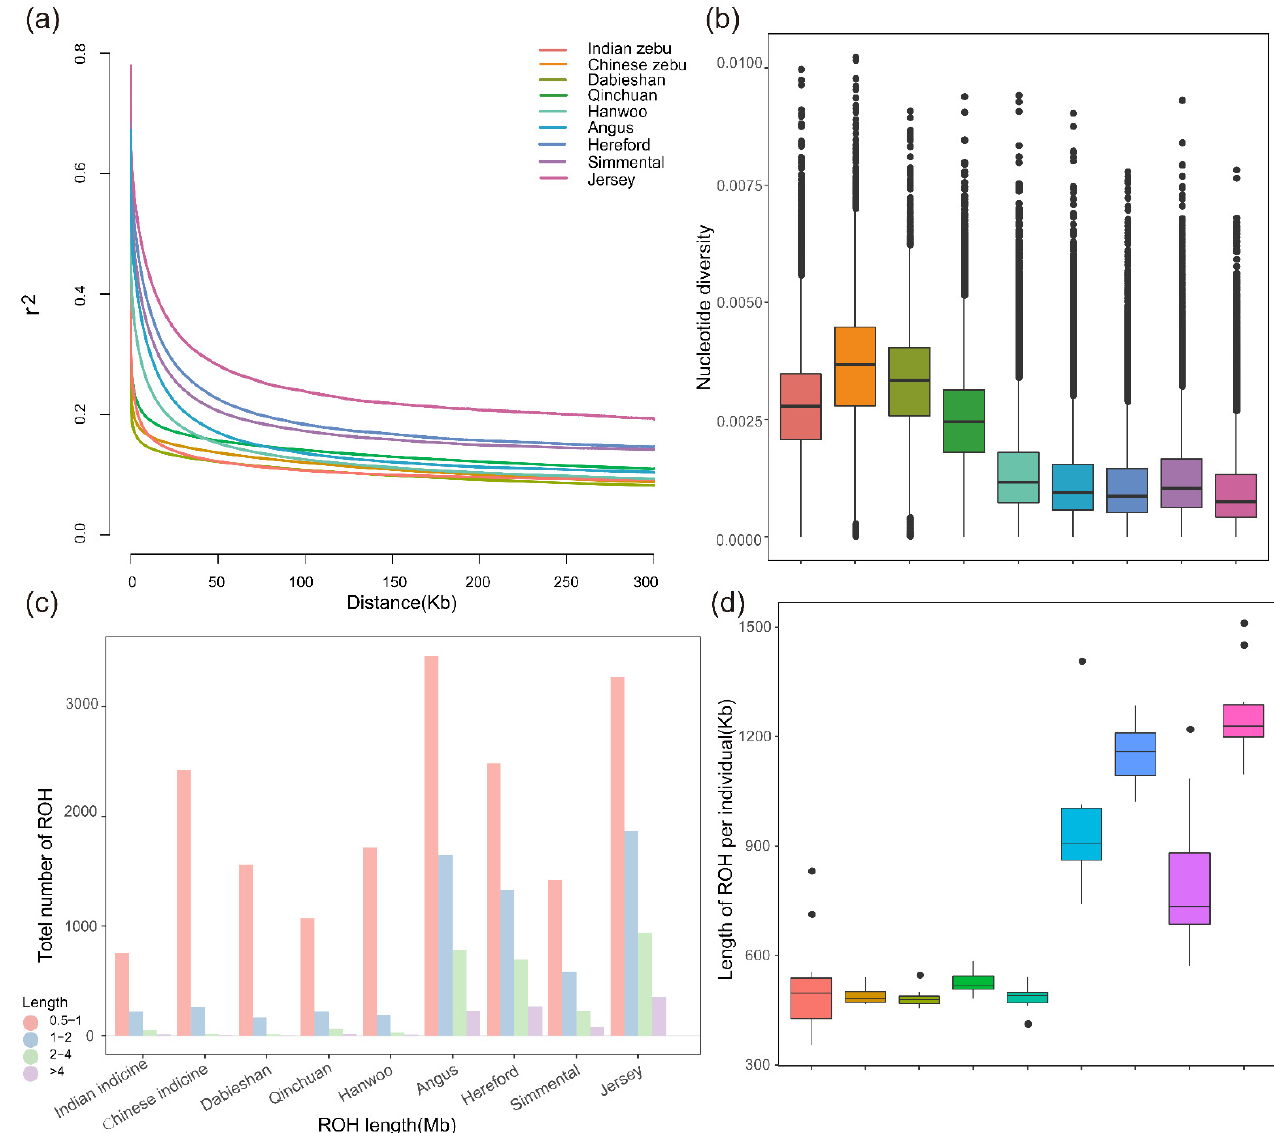
Figure 2. Genetic diversity among nine population. ( a ) The average LD decay calculated per group on whole-genome autosome. ( b ) Nucleotide diversity at a whole-genome scale of each group. The horizontal line inside the box indicated the median of this distribution and dots can be considered as outliers. ( c ) The distribution of lengths ROH in four categories: 0.5–1, 1–2, 2–4, >4 Mb. ( d ) The length of ROH estimated from each population.